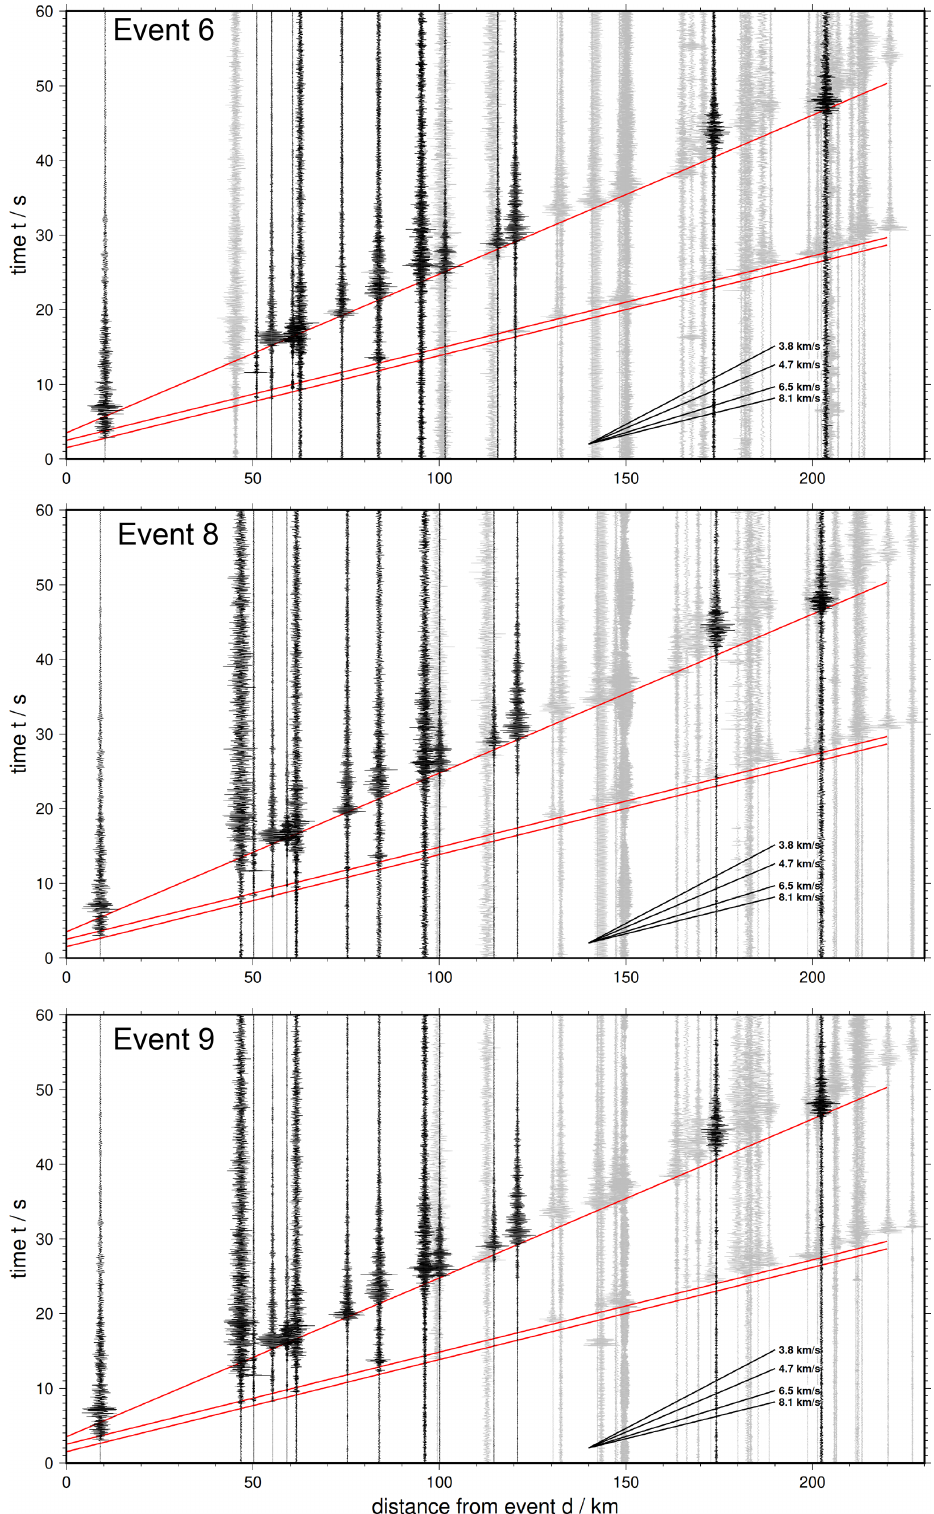
Figure A1. Waveforms observed at stations displayed over offset. Black traces were used for earthquake location. Red lines mark the weak P onset, followed by stronger Ps and S phases. Apparent velocities of Vp = 8.1kms − 1 and Vs = 4.7kms − 1 observed for the phase onsets (marked with red